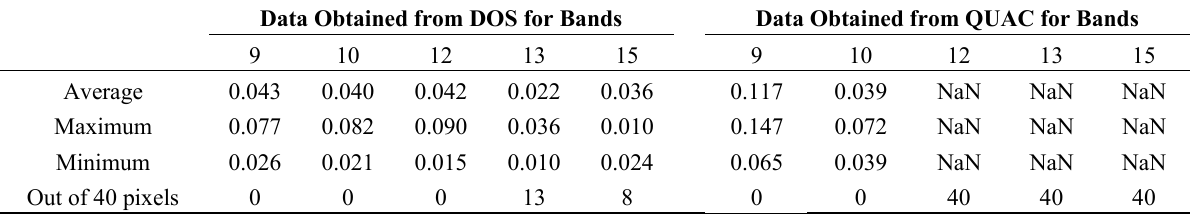
Table 1. Descriptive statistics of reflectance data obtained at 40 pixels of the Moderate Resolution Imaging Spectroradiometer (MODIS) image data corresponding to the locations of water sampling points. Two atmospheric correction methods, dark-object subtraction (DOS) and Quick Atmospheric Correction (QUAC), were used to determine the reflectance at primary ocean color bands. NaN stands for “not a number”. Data Obtained from DOS for Bands Data Obtained from QUAC for Bands